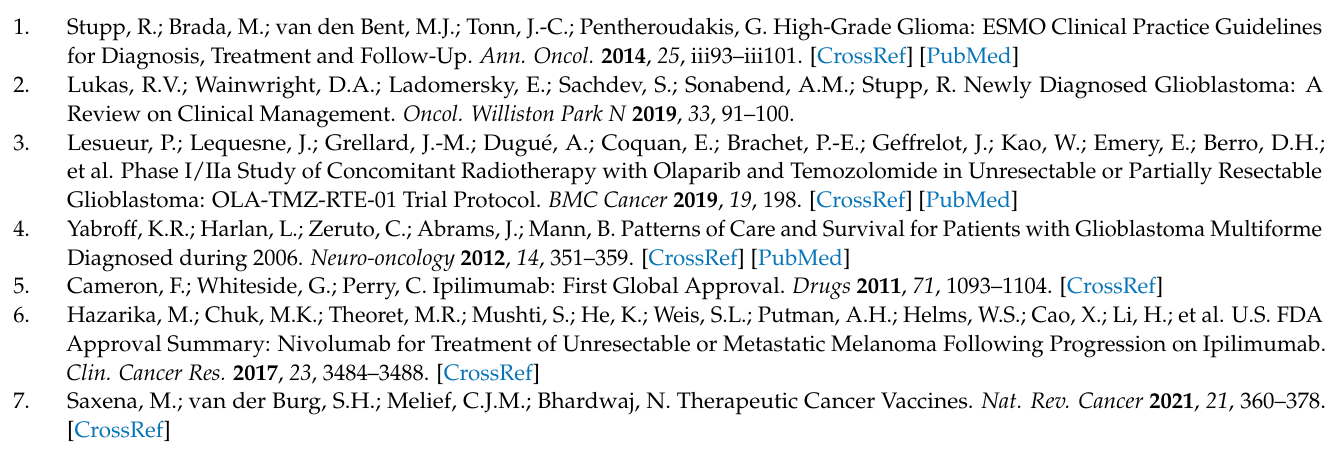
G. The possible insertion sites are colored in blue; Figure S2. FACS gating strategy for T cell analysis; Figure S3. Follow-up of tumoral growth by MRI. A representative mouse was selected for each group; Figure S4. Rechallenge of long-term survivors. (A) Comparison of tumor volumes between the three groups. Values are mean ± SEM; n = 3–6. (B) Evolution of tumor volumes of each mouse from the untreated group; n = 6. (C) Survival curves following rechallenge of long-term survivors from the group treated with ICBs and with the combination; n = 3–6. Statistical analyses were performed using Mantel–Cox test (** p <